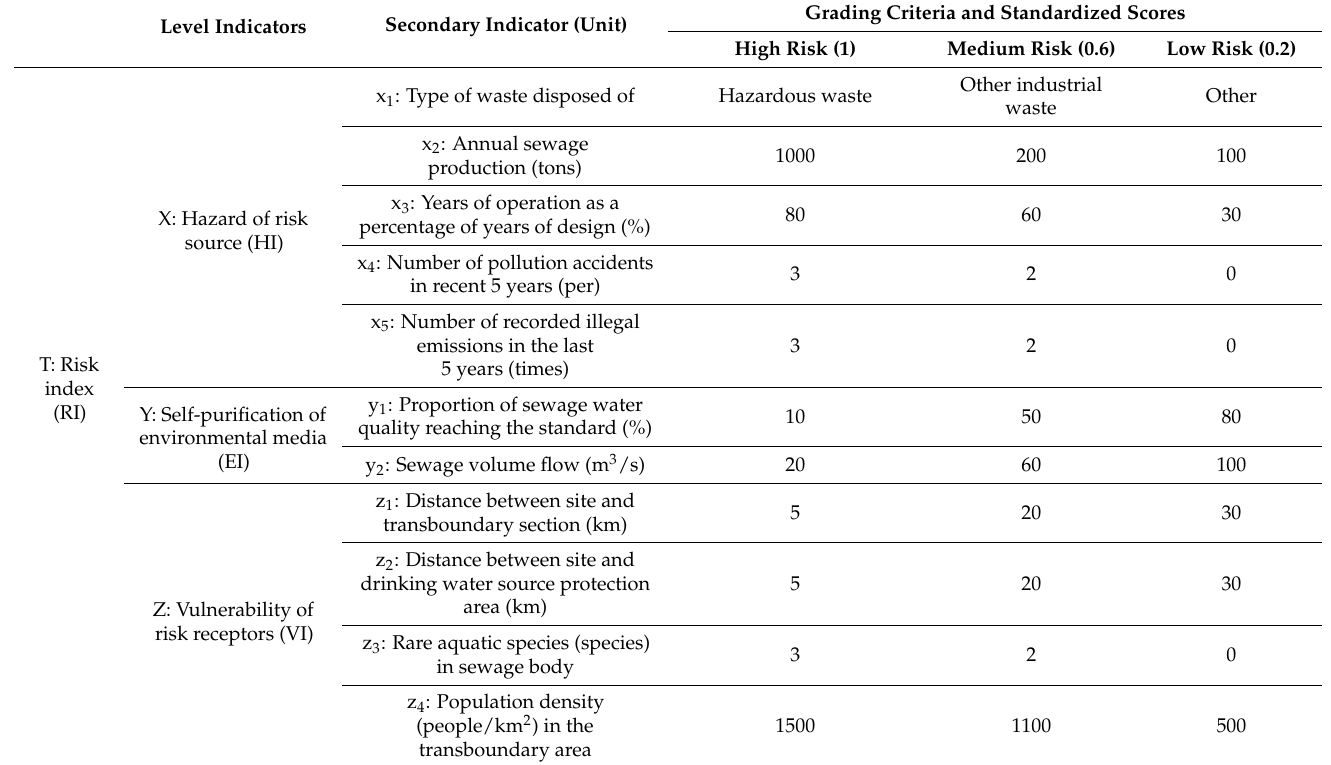
Table 2. Risk assessment index system for centralized waste treatment and disposal sites in cross- border areas.